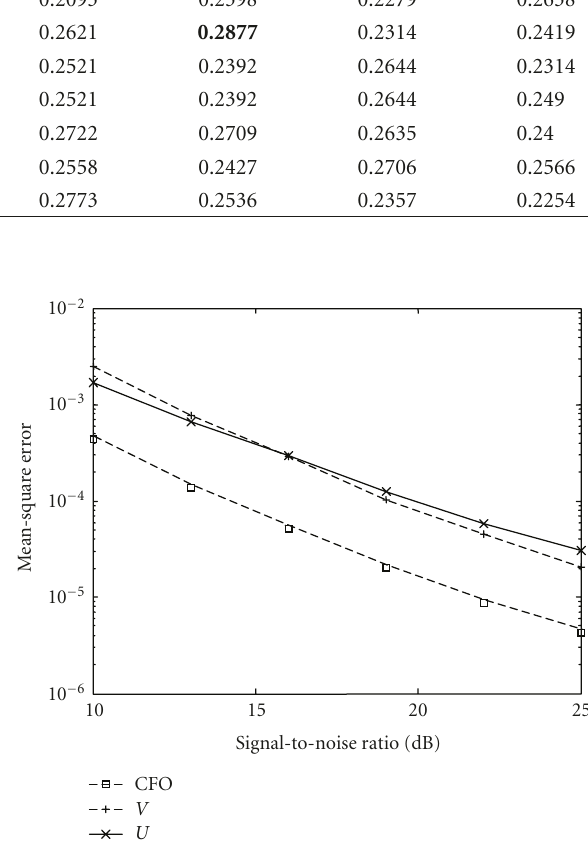
Figure 6: MSE of I/Q imbalance estimate versus SNR ( U = tgθ , V = 1 /g cos θ , and ε = 0 .